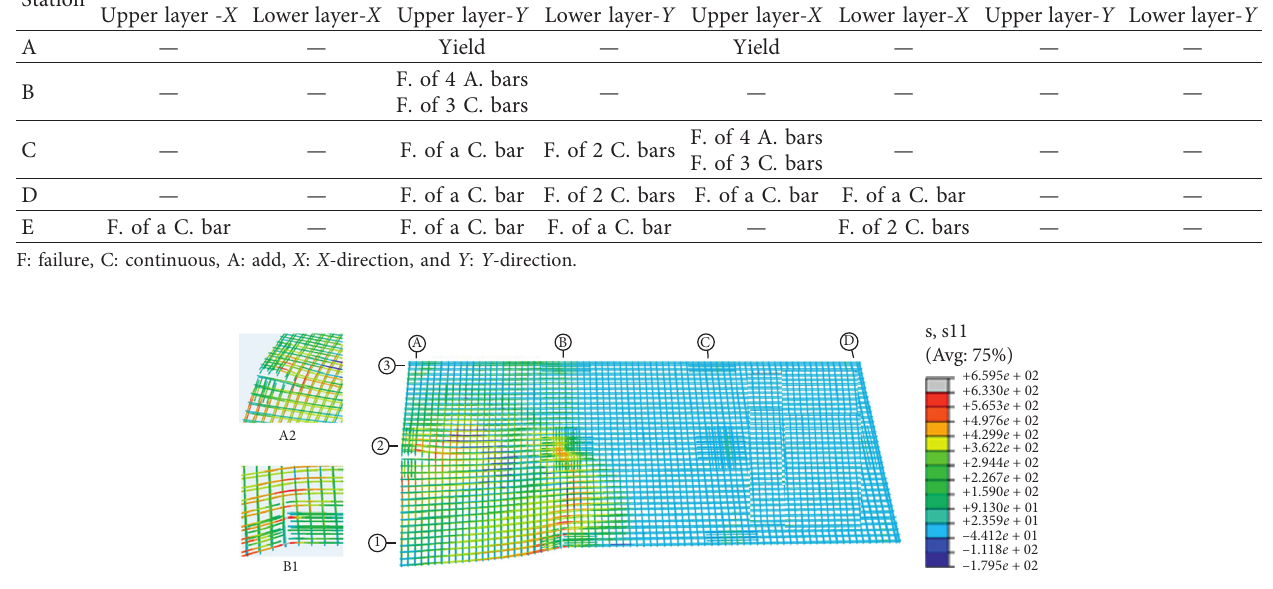
Table 3: Summary of stress state of flat slab bars around columns A2 and B1 of the model RC. Slab bars around column A2 Slab bars around column B1 Station